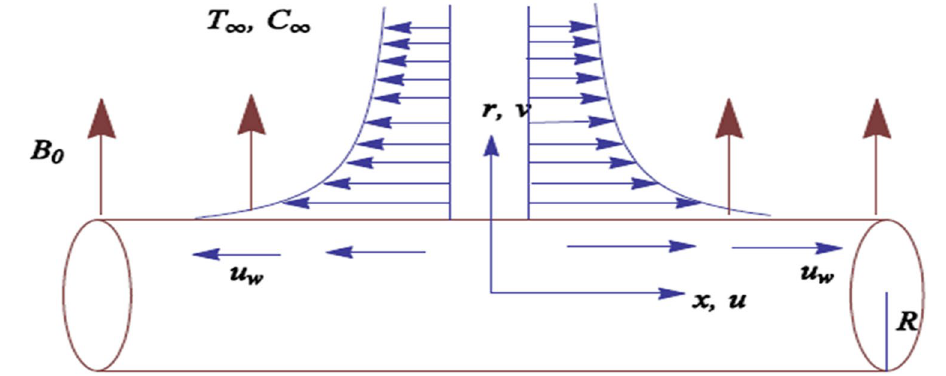
Figure 1. The geometry of the